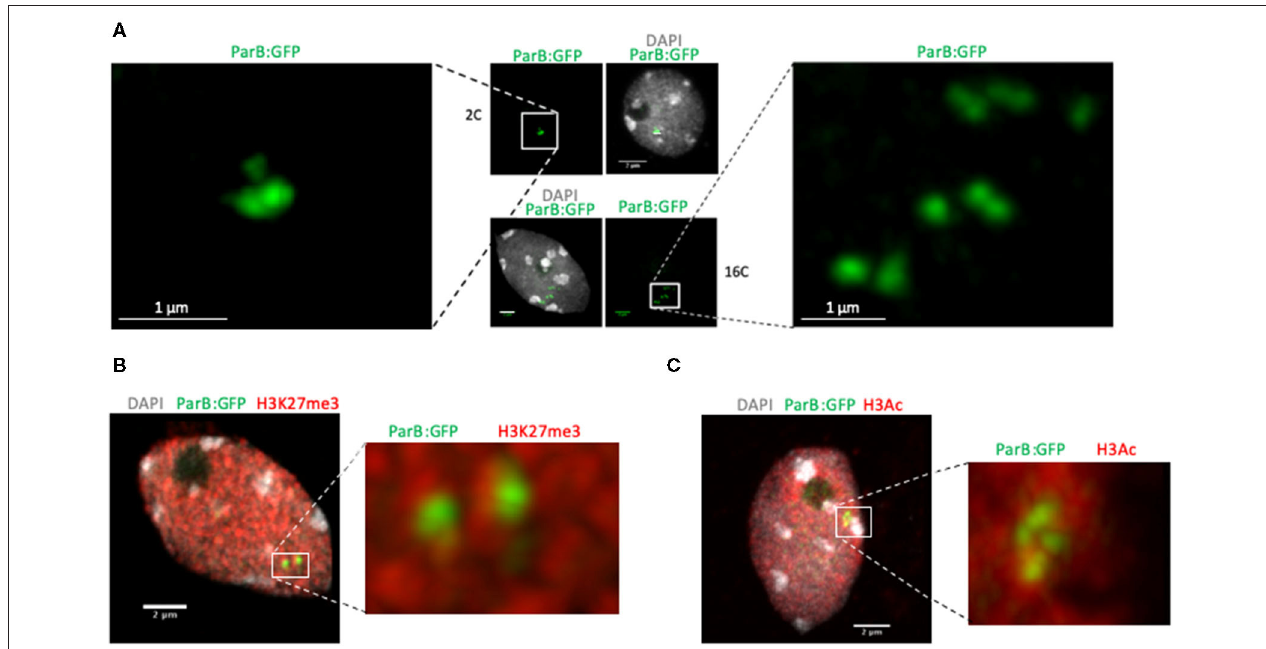
FIGURE 2 | Detection of parS -ParB foci in cells with different ploidy levels and after immunolocalization experiments. (A) Detection of parS -ParB:GFP foci (green) in fixed and sorted nuclei according to their ploidy levels by fluorescent-assisted cell sorting. Nuclear DNA is labeled with DAPI (gray). Enlarged view of the parS -ParB:GFP foci is presented to facilitate signal visualization. Bar = 1 µ m. (B,C) Detection of parS -ParB:GFP foci (green) and posttranslationally modified histones (red) in fixed and isolated nuclei from A. thaliana Col-0 plants T2F. The image corresponds to a confocal 2D stack. Nuclear DNA is labeled with DAPI (gray). Trimethylated H3K27 signals are shown in (B) , while acetylated H3 are shown in (C) . Enlarged views of the parS -ParB:GFP foci are presented to facilitate signal visualization. Bar = 2 µ